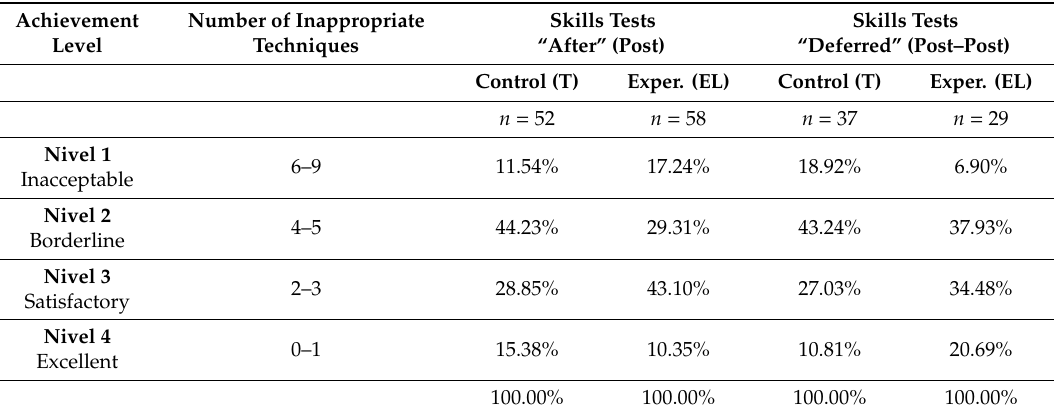
Table 9. Achievement level reached in technical